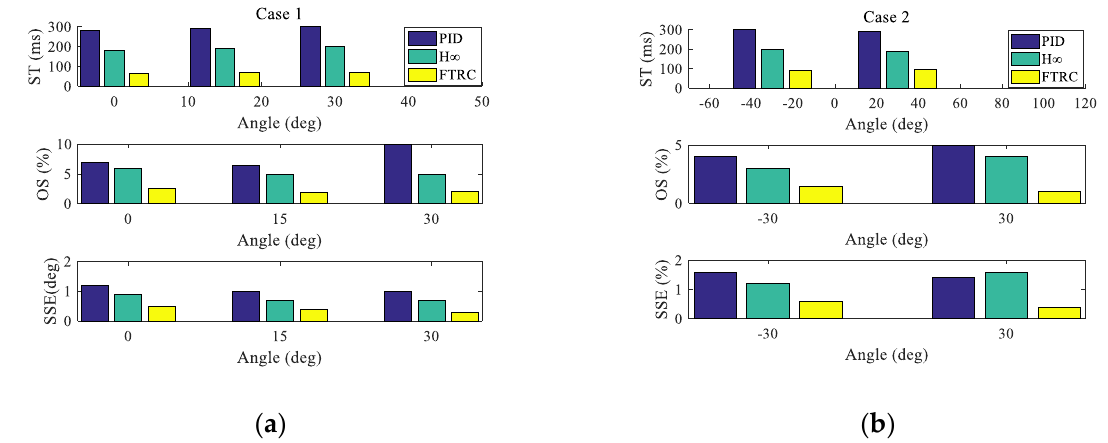
Figure 15. Setting time, overshoot and steady state error under Cases 1 and 2.